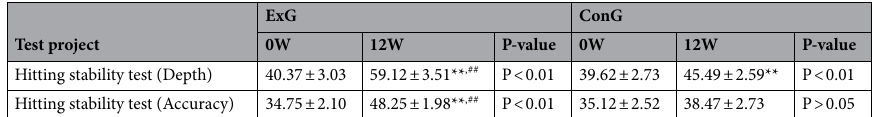
Table 8. We performed a 2 (group: ExG, ConG) × 2 (time: 0w, 12w) repeated measures ANOVA on the sub- jects’ batting stability. The results showed that the batting stability test (depth) index had significant group main